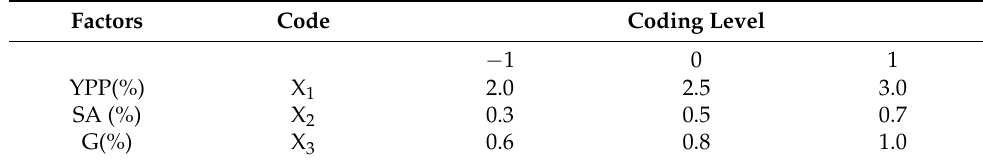
Table 1. Experiment factor, level and